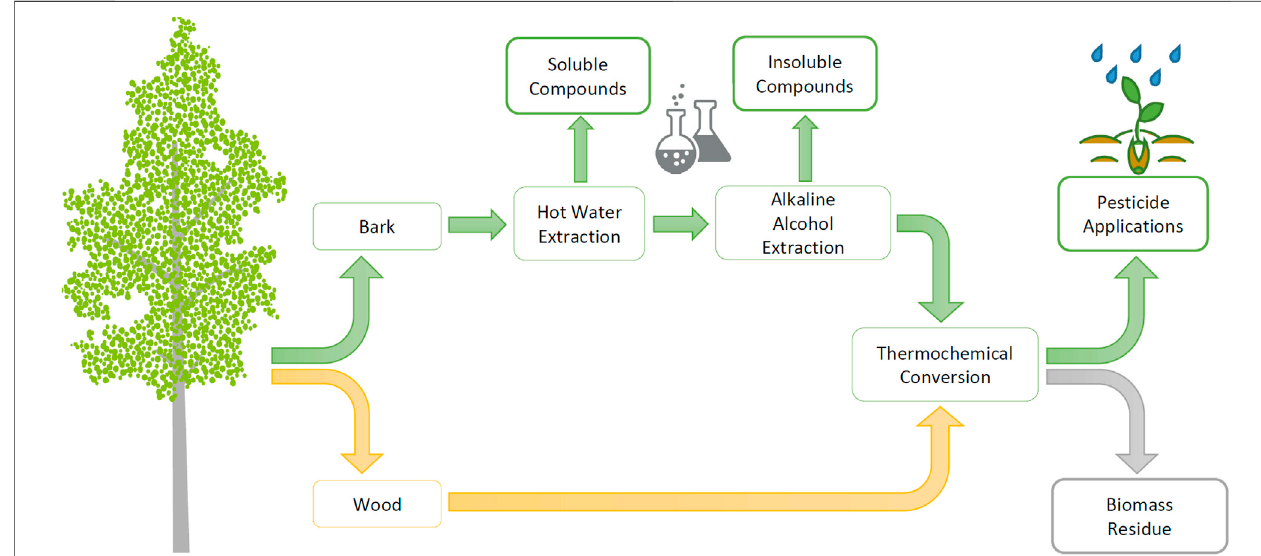
FIGURE 1 | Utilization of hybrid aspen biomasses in the production of biopesticides according to the cascade principle.